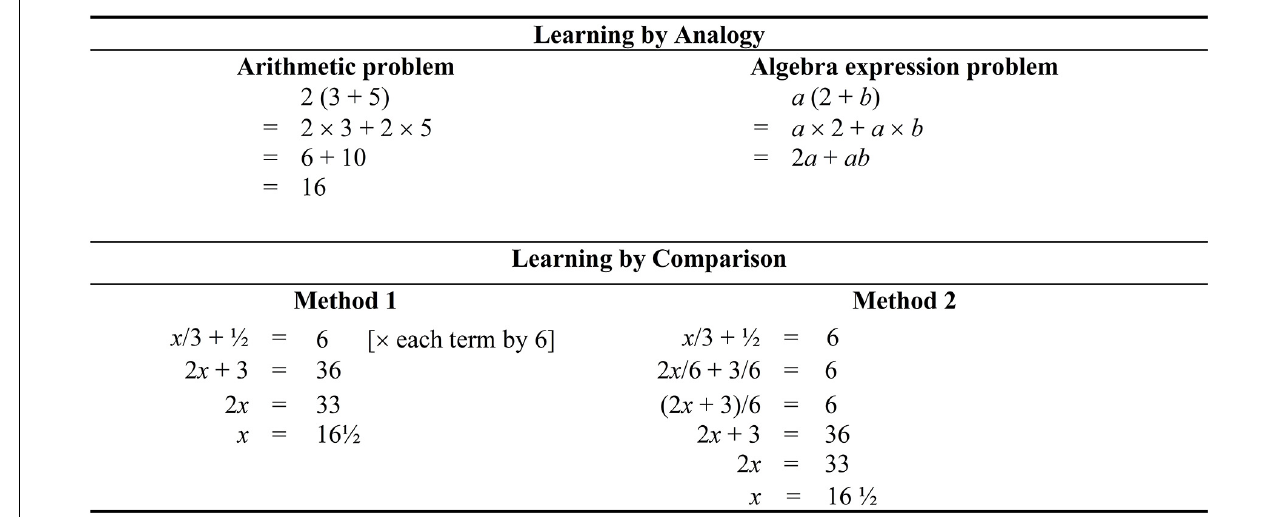
FIGURE 7 | Examples of mathematics learning via learning by analogy and learning by